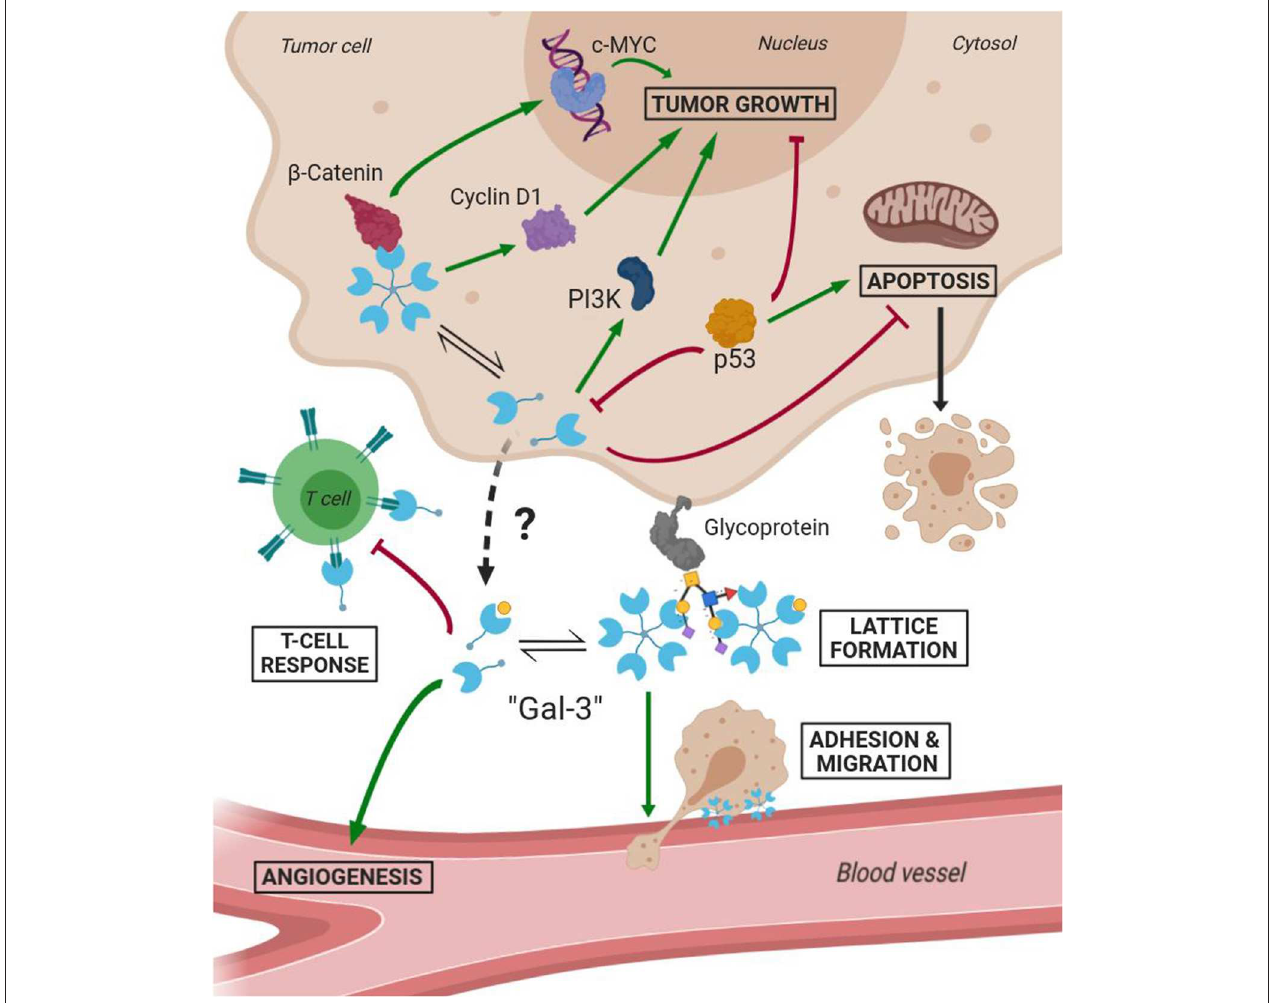
FIGURE 7 | Scheme of Gal-3 most important cellular functions in tumoral environments (Green arrows mean activation and bordeaux lines mean inhibition).